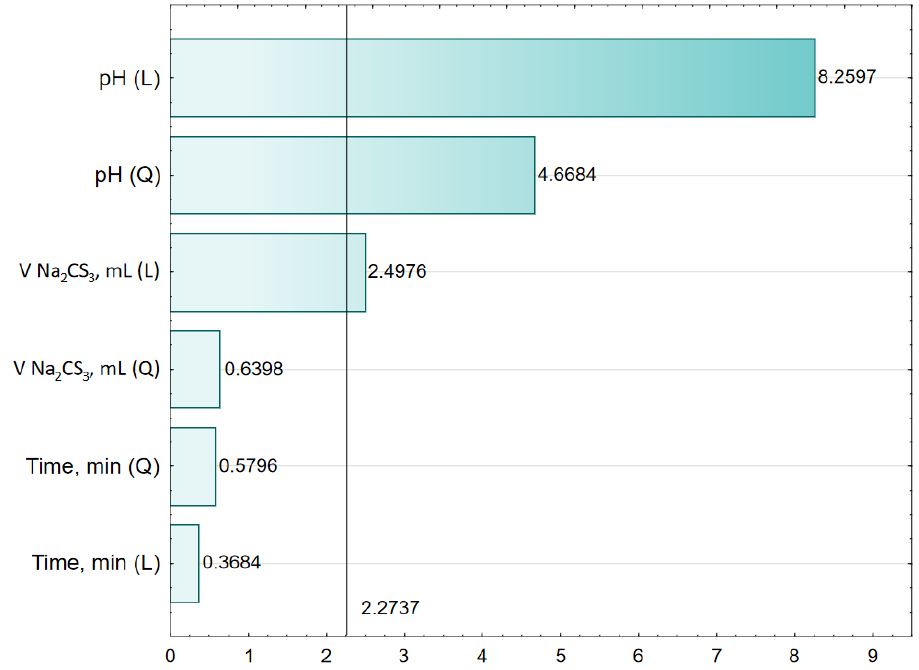
Figure 3. Bar chart of standardized effects (3 value, 1 block, 16 experiments, MS = 0.0320, R 2 = 0.9173, R 2adj = 0.8622, L—linear effect, Q—quadratic effect, 2.2737—the absolute value of the standardized effect assessment for p = 0.05).